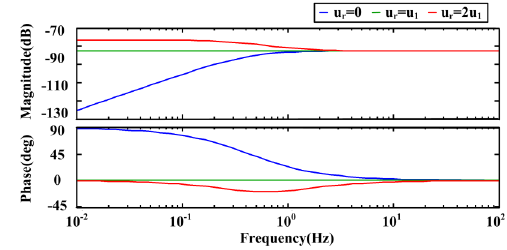
Figure 3. Frequency response curves of the simplified model at different radial velocity.